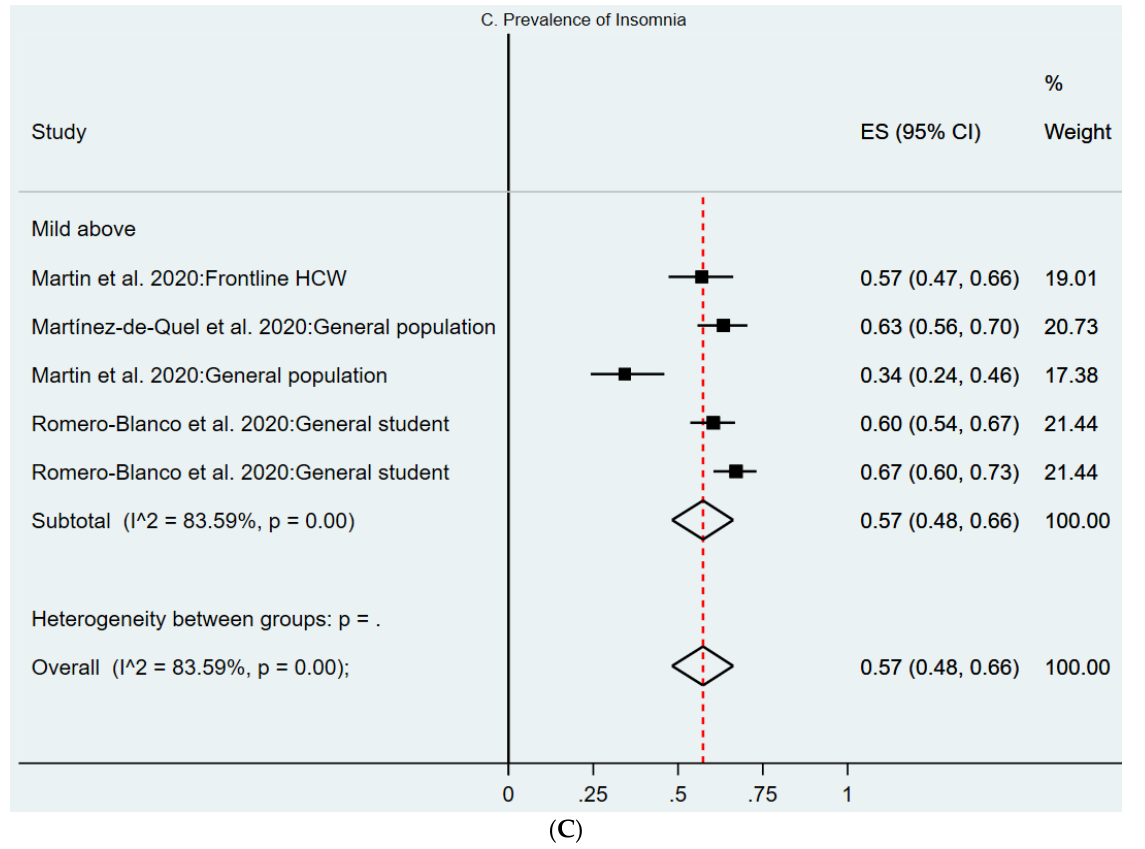
Figure 2. ( A – C ). Forest plot of the prevalence of anxiety, depression and insomnia. Figure legend: The square markers indicate the prevalence of the symptom at the different level for different populations. The size of the marker correlates to the inverse variance of the effect estimate and indicates the weight of the study. The diamond data marker indicates the pooled prevalence.